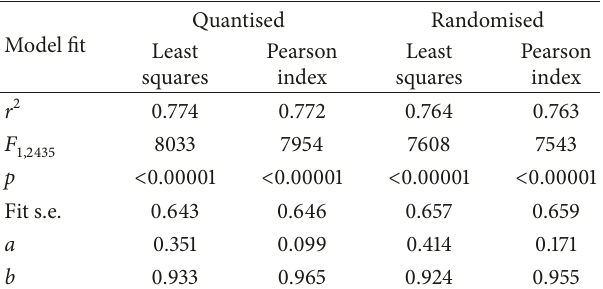
Table 3: Model parameters (rounded to three significant figures) for the linear model of field pH against lab pH using both the least squares and Pearson index for the quantised and randomised data.